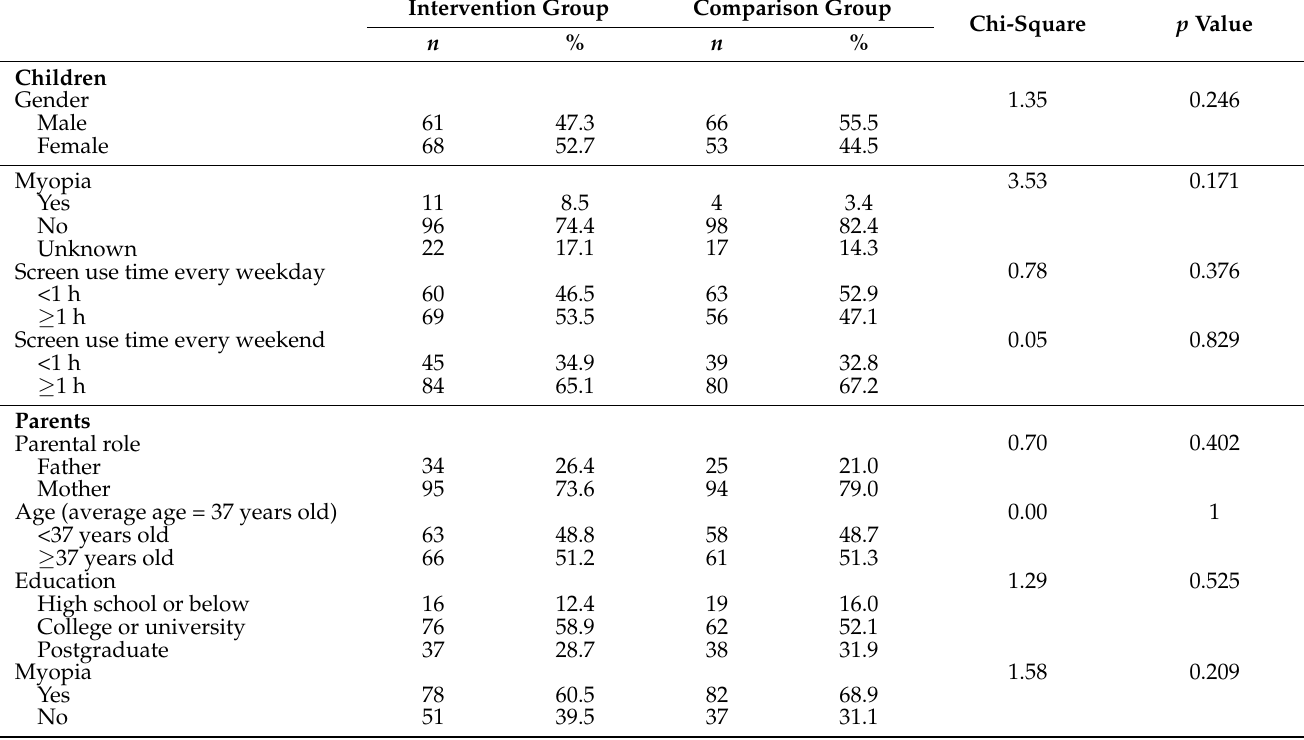
Chi-Square p Value